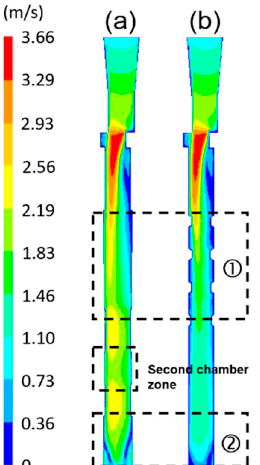
Figure 6. (Color) ( a , b ) Contours of velocity in a vertical view for Nozzle A and Nozzle B. Three vertical lines drawn along the nozzles help to quantify the changes in the flow: The first one at the left side, corresponds to the aperture side of the slide gate, the second at the center of the nozzle, and the third at the right side, opposite to the aperture of the slide gate. The velocity profiles along these lines are in Figure 7. Regarding nozzle A, there is a decrement of about 30% on the left side compared to the entry and exit velocities. There is no velocity difference at the center, and the velocity at the right side increases considerably to about 86%. The second chamber zone yields no significant velocity difference. The velocities of the left and center lines are closer in magnitude while the right side remains with a smaller velocity. Although these chambers work as a countermeasure for the radial asymmetry of the steel flow, produced by the slide gate in a significant way, the steel reaching the nozzle ports maintains a significant asymmetry yet. This condition may prevail along with the discharging jets inside the mold.